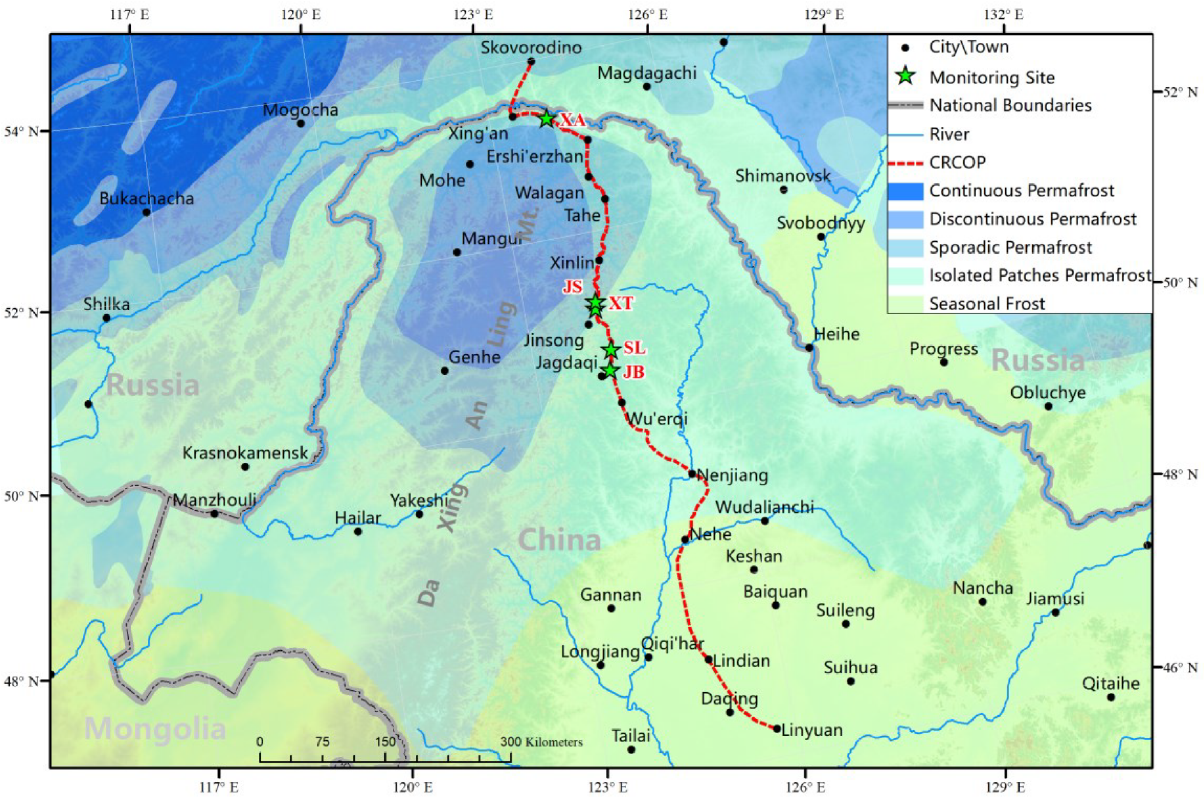
Figure 1. Location of permafrost monitoring sites along the route of China–Russia crude oil pipelines (CRCOPs). Permafrost zone from Jin et al. (2007, 2010). The dashed red line represents the paralleling CRCOPs I and II (the inter-pipeline distance is generally limited to approximately 10m). Table 1. Permafrost characteristics for monitoring sites along the route of China–Russia crude oil pipelines. Site Lat. Long.